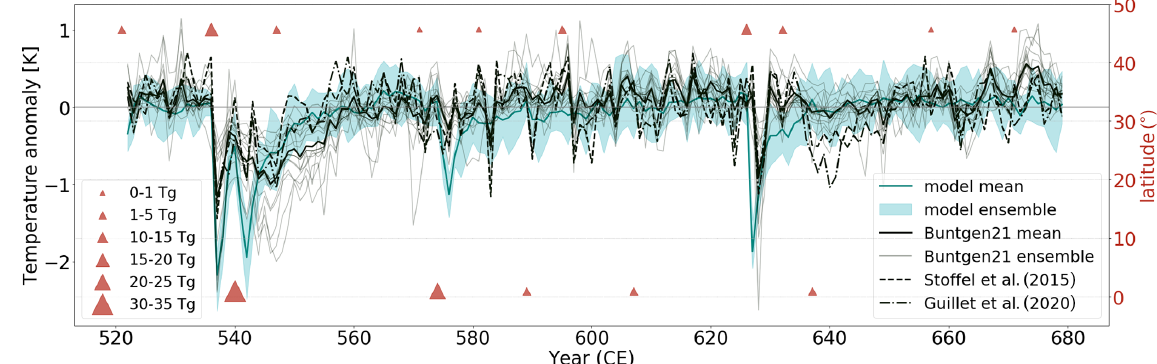
Figure 6. Model–tree ring comparison for the NH. The model 2m air temperature anomalies are taken for land only, JJA, and 40 to 75 ◦ N. Climate model mean and the spread of the model ensemble; tree ring data for NH1 (Stoffel et al., 2015), N-VOLCv2 NH reconstruction (Guillet et al., 2020), and the mean and the ensemble of Büntgen et al. (2021). Anomalies are with respect to 1–1850CE except for the Guillet et al. (2020) data, which are with respect to